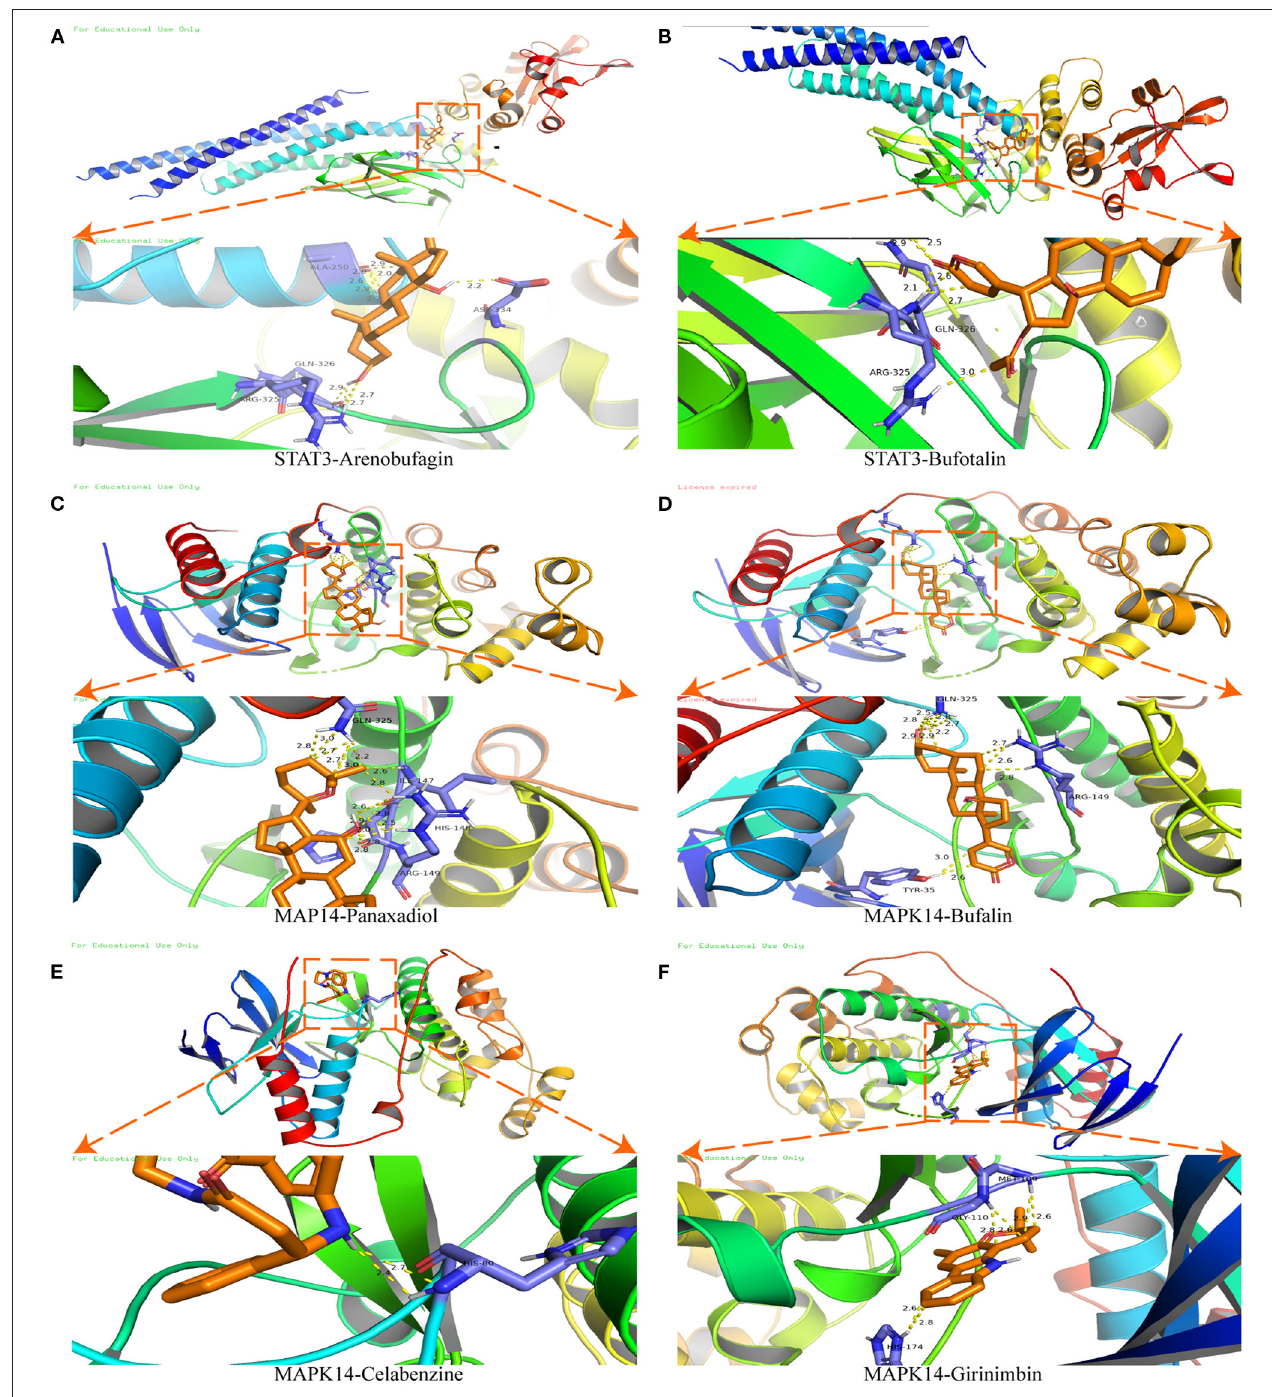
FIGURE 6 | Molecular docking of STAT3 and MAPK14. (A) Molecular docking between STAT3 and arenobufagin. (B) Molecular docking between STAT3 and bufotalin. (C) Molecular docking between MAPK14 and panaxadiol. (D) Molecular docking between MAPK14 and bufalin. (E) Molecular docking between MAPK14 and celabenzine. (F) Molecular docking between MAPK14 and MAPK14-girinimbin.